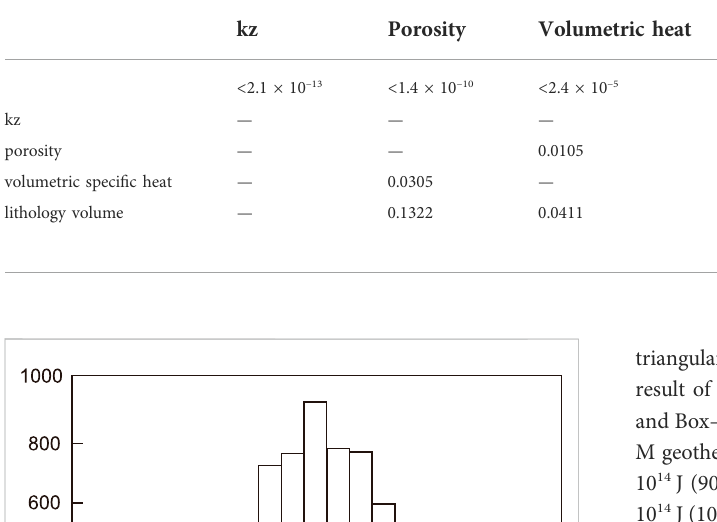
TABLE 3 The p -value of parameters applied in building a Box – Behnken design second-order model with interactions.